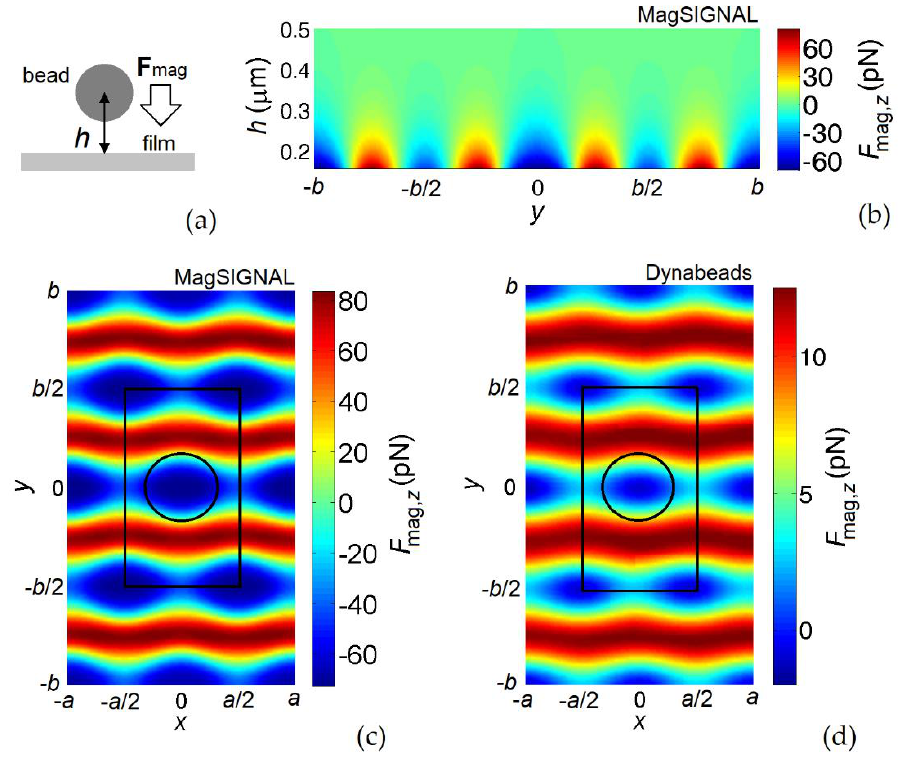
Figure 2. ( a ) Schematic of bead trapping. ( b ) Map of the vertical component of the magnetic force for MagSIGNAL-STA beads, calculated on a plane orthogonal to the permalloy nanostructured film (with d hole = 330 nm) and parallel to the longer side of the unit cell. Maps of the vertical component of the magnetic force calculated on a plane parallel to the film for ( c ) MagSIGNAL-STA and ( d ) Dynabeads MyOne beads. The beads are assumed to be in contact with the film surface. For all maps, the applied bias field is equal to 150 kA/m.